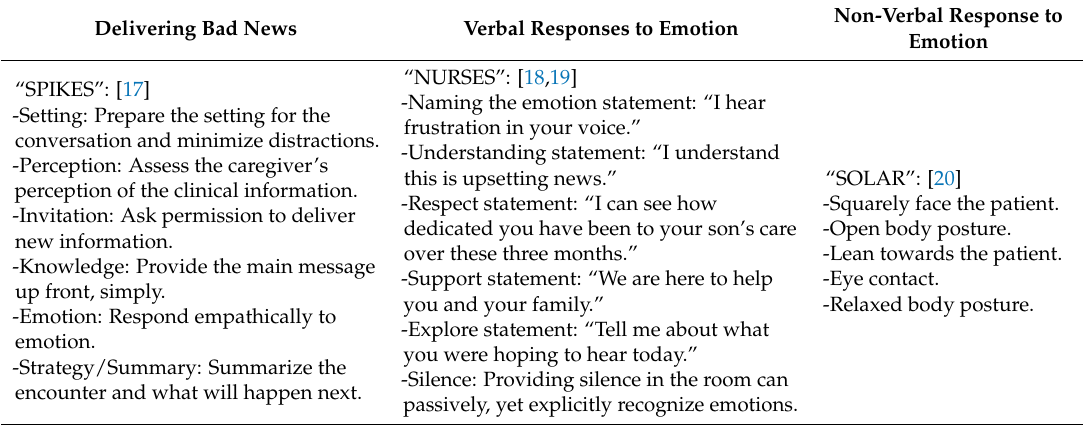
Table 1. Palliative care communication